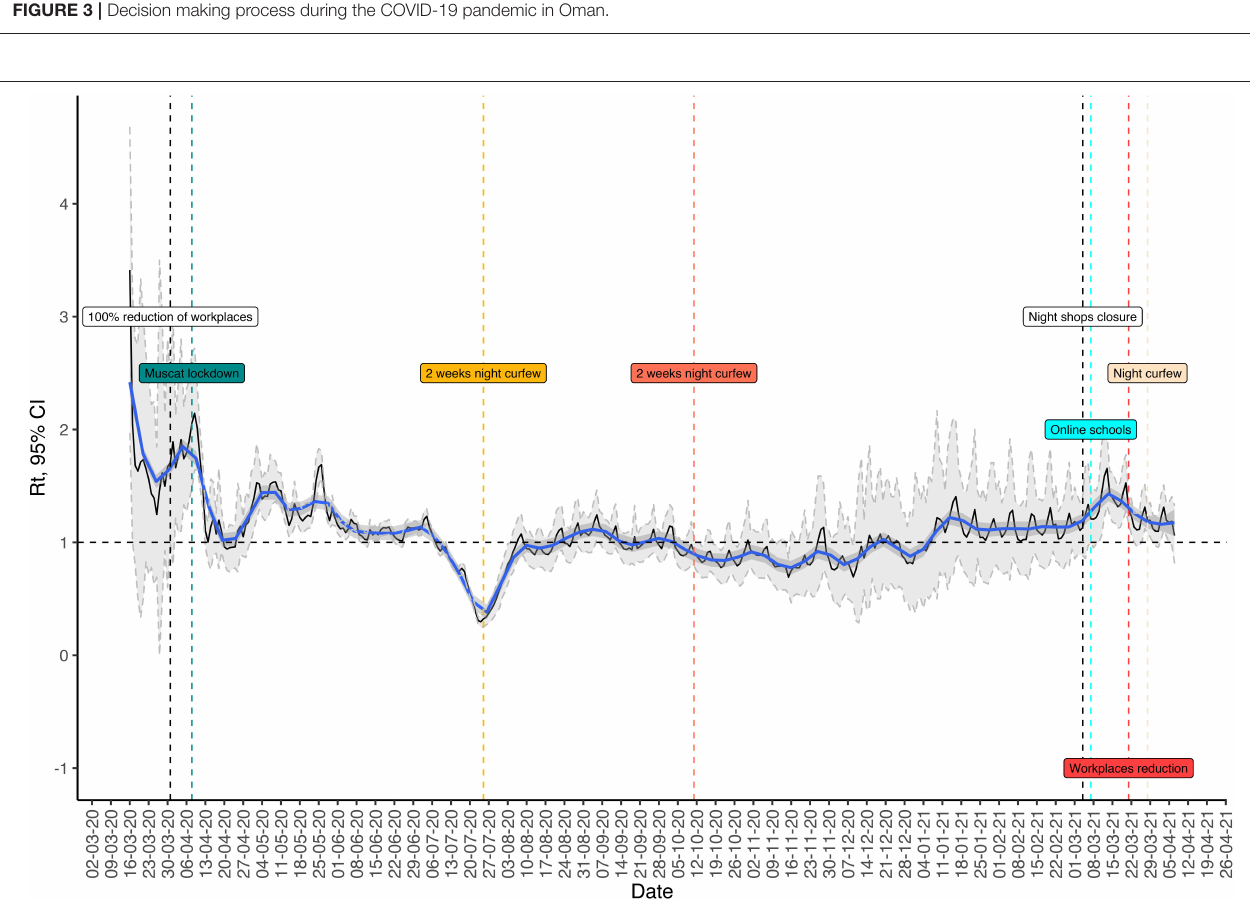
FIGURE 4 | The relationship between the reproduction number and different public health measures during COVID-19 pandemic in Oman.